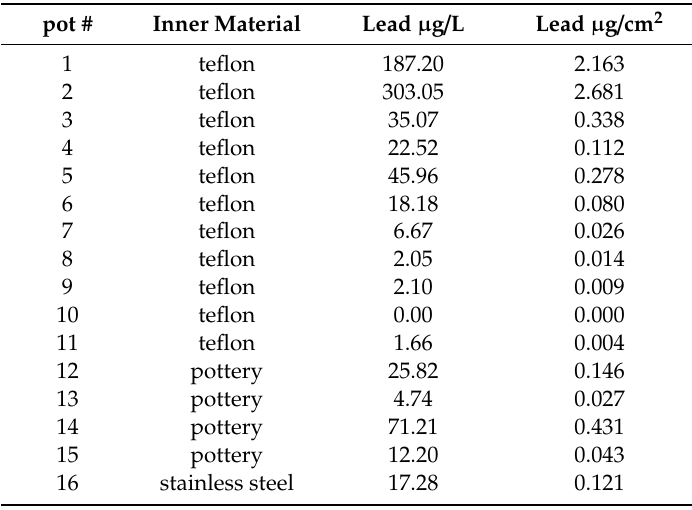
Table 2. Migration test on cooking pots and pottery.